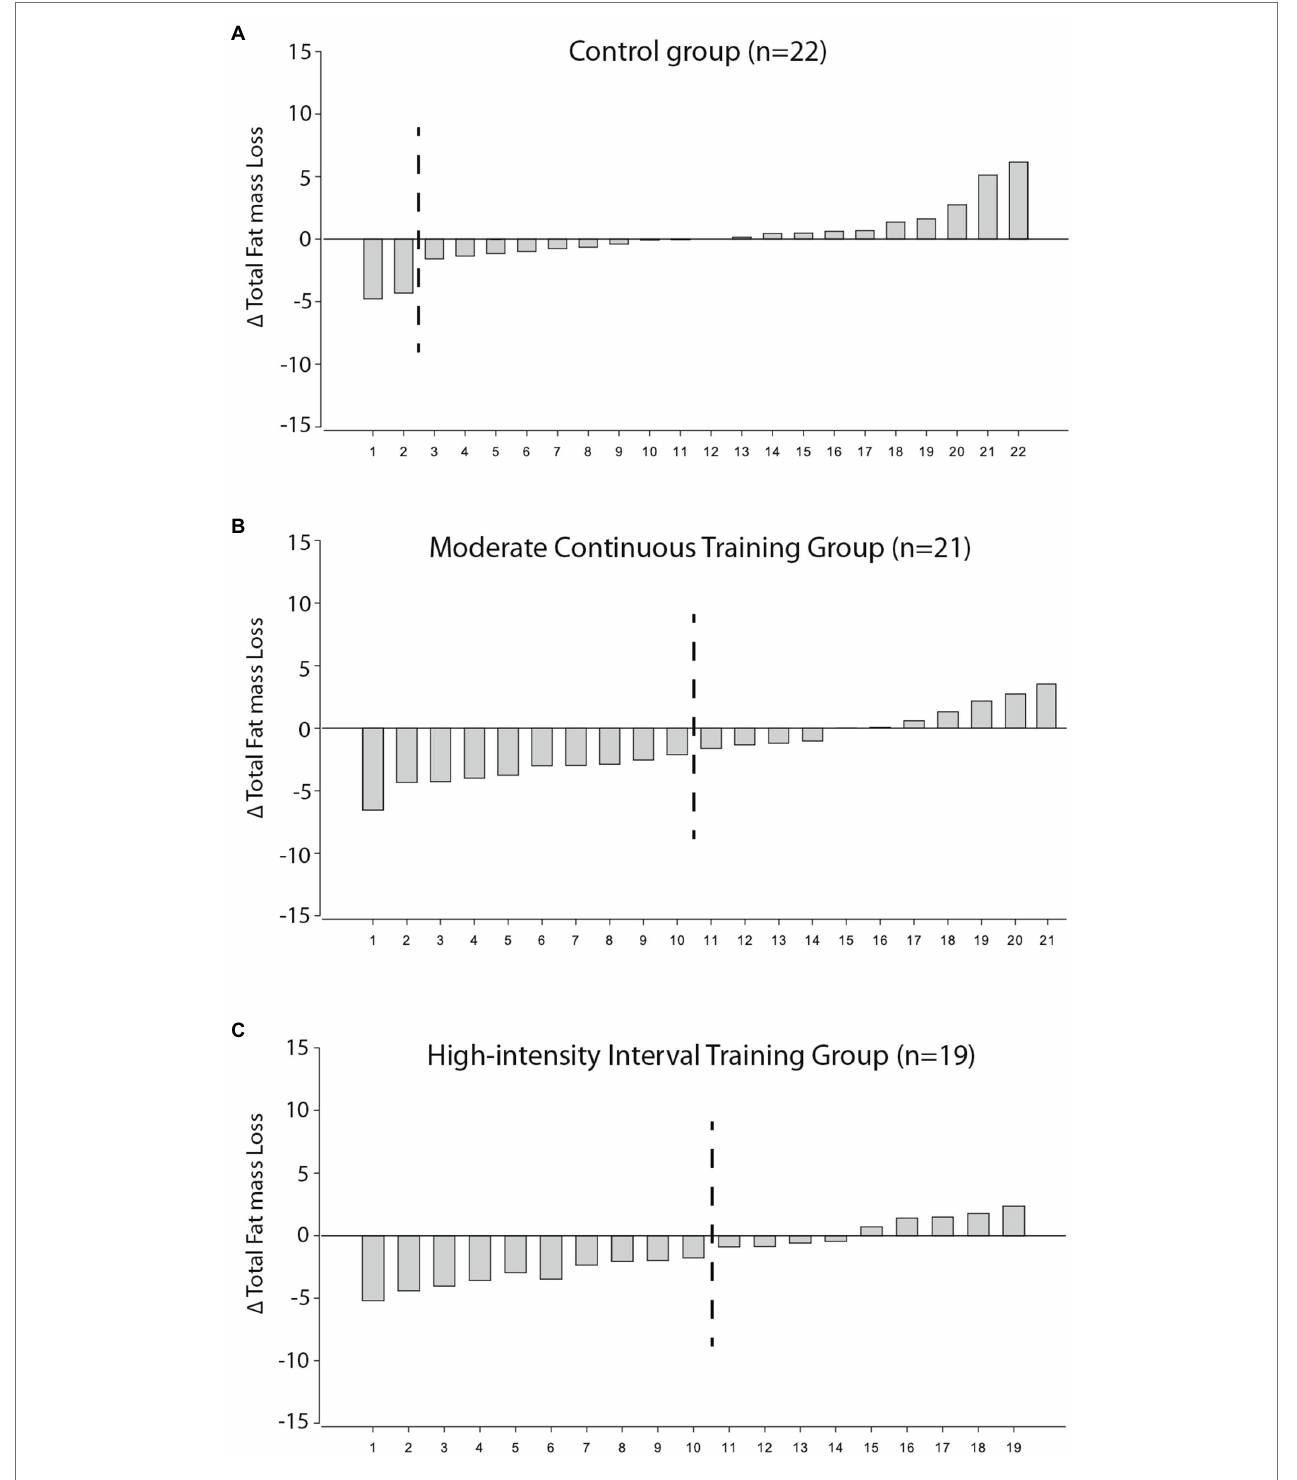
FIGURE 1 | Individual response changes for total FM loss in the control (A) , MCT (B) , and HIIT group (C) according to 90% CI SWC cutoffs. Those on the left of the dashed black line are the participants who were considered high responders according to Δ FM loss>TE. TE, typical